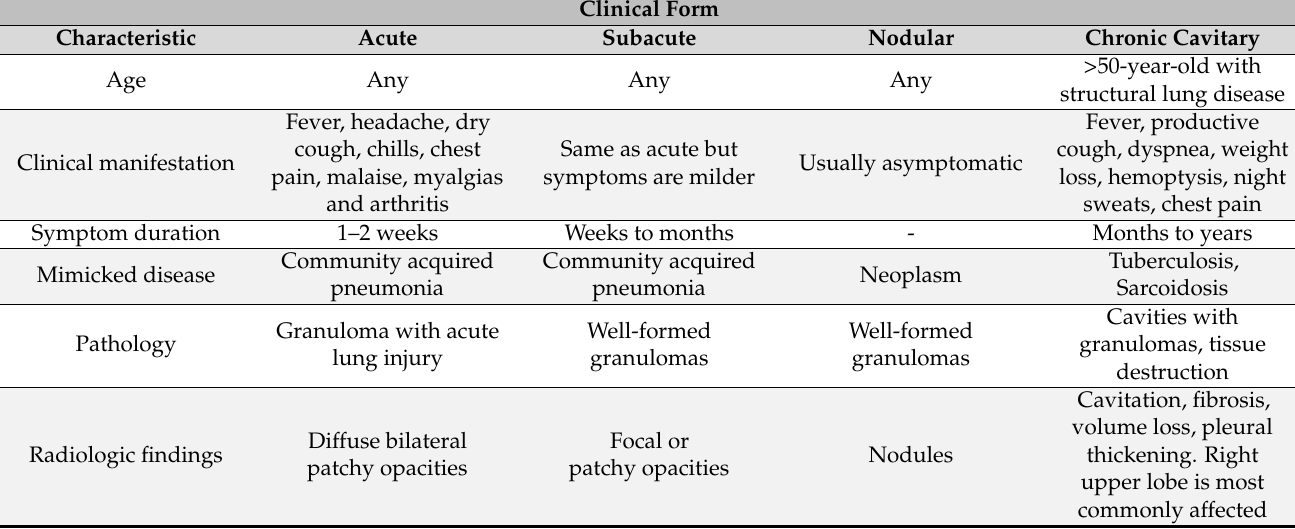
Table 2. Key features of pulmonary